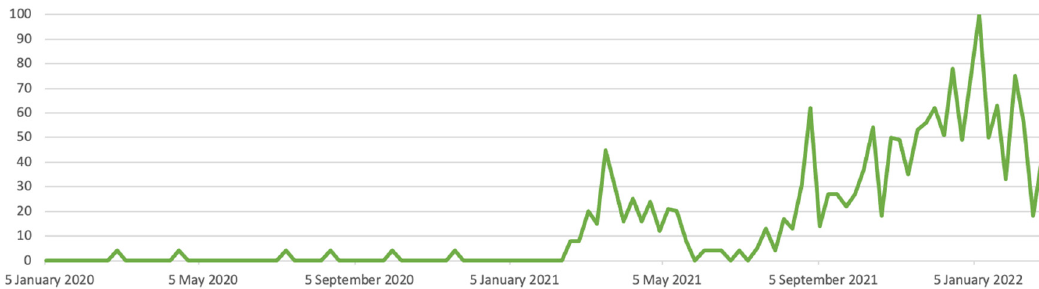
Figure 3. Worldwide searched term on Google for “NFT Sound”.